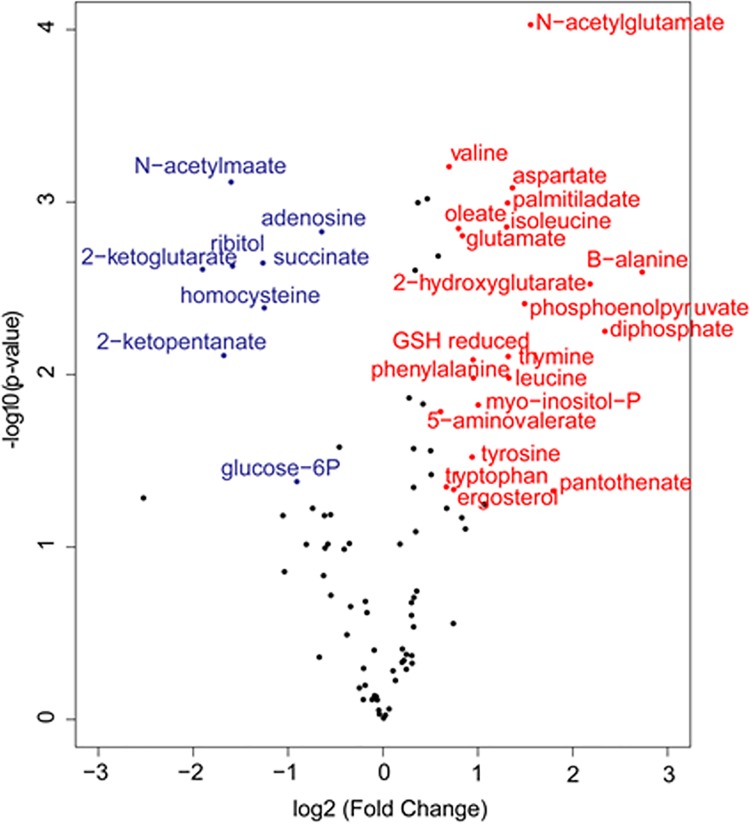
Volcano plot comparing the hva1Δ and H99W strains.Metabolites that are elevated in the hva1Δ strain versus H99W are red, while those that are decreased in the hva1Δ strain versus H99W are blue. To be colored the fold change must be greater than 1.5 and p-value<0.05. These data are suggestive of a block in the in the production of 2-ketoglutarate in the hva1Δ strain compared to H99W.